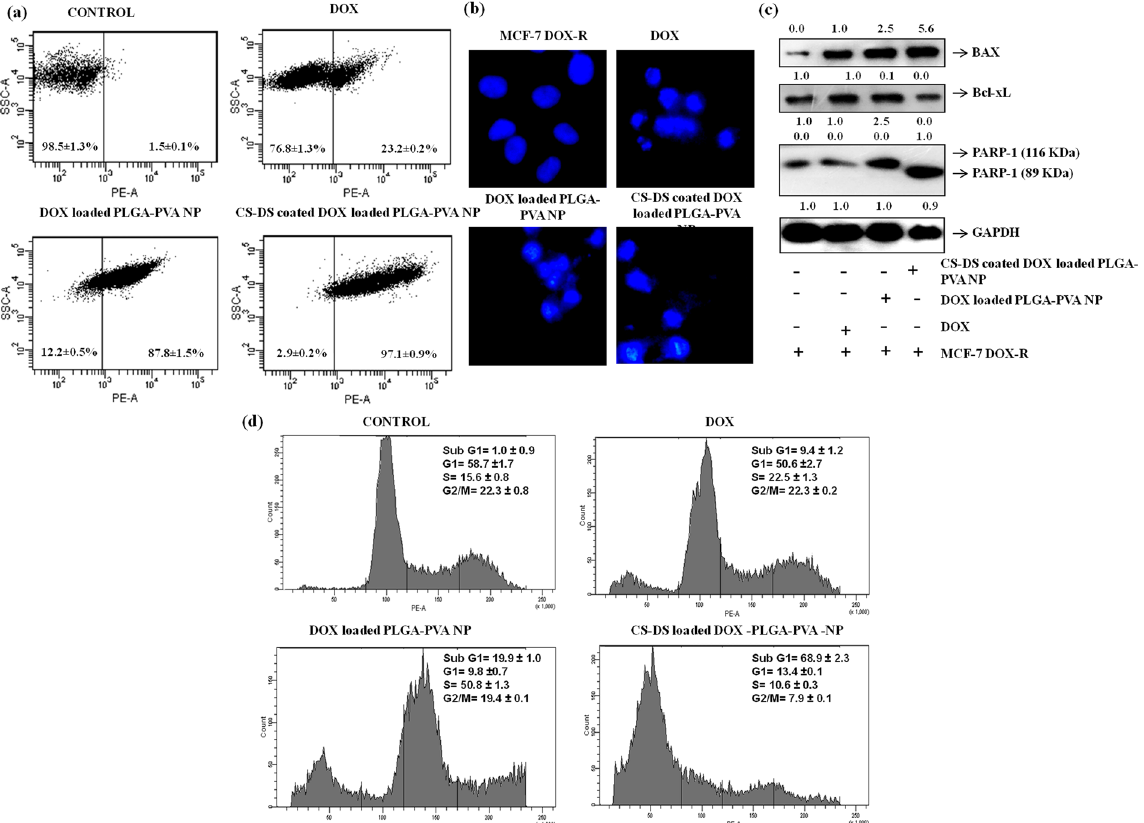
Figure 4. CS-DS coating on DOX loaded PLGA-PVA- NP enhances the uptake of DOX and induces apoptosis in MCF-7- DOX-R cells. ( a ) Cellular uptake of DOX and DOX -NP in MCF-7-DOX-R cells measured by FACS. Data represents mean ± S.E.M. of three different experiments. ( b ) Apoptotic nuclei of DOX and DOX- NP treated MCF-7- DOX-R cells after DAPI staining. Images are representative of three independent experiments. ( c ) Western blot analysis of BAX, Bcl-Xl and PARP-1 in drug treated cellular lysate of MCF-7- DOX-R cells. Data was the one of the replica of three different experiments. ( d ) Regulation of cell cycle profile after treatment with DOX and DOX NP in MCF-7- DOX-R cells. Data was the one of the replica of three different